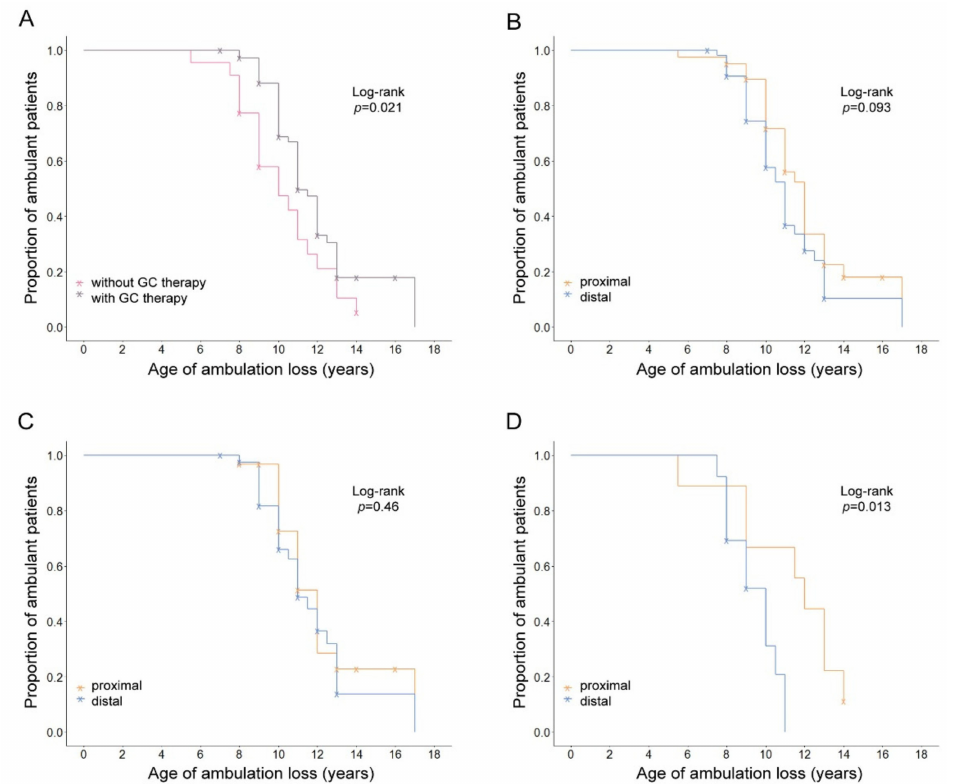
Figure 1. Kaplan–Meier plots showing the effect of GC therapy and mutation location on age at LoA for 95 patients with Duchenne muscular dystrophy. ( A ) The two survival lines represent patients stratified by GC therapy, where GC-treated patients had a later age at LoA compared to untreated patients. ( B ) The two survival lines represent patients stratified by mutation location within the DMD gene, where patients with the proximal location showed a trend of later age at LoA compared to patients with the distal location. The effect of mutation location was not significant in ( C ) patients with GC therapy, while, in ( D ) patients without GC therapy, proximal location was shown to have a protective effect. Log-rank test was used to compare different Kaplan–Meier curves, and the corresponding p -values are shown on the top right corner of all plots. Censored patients are indicated with a cross on their survival